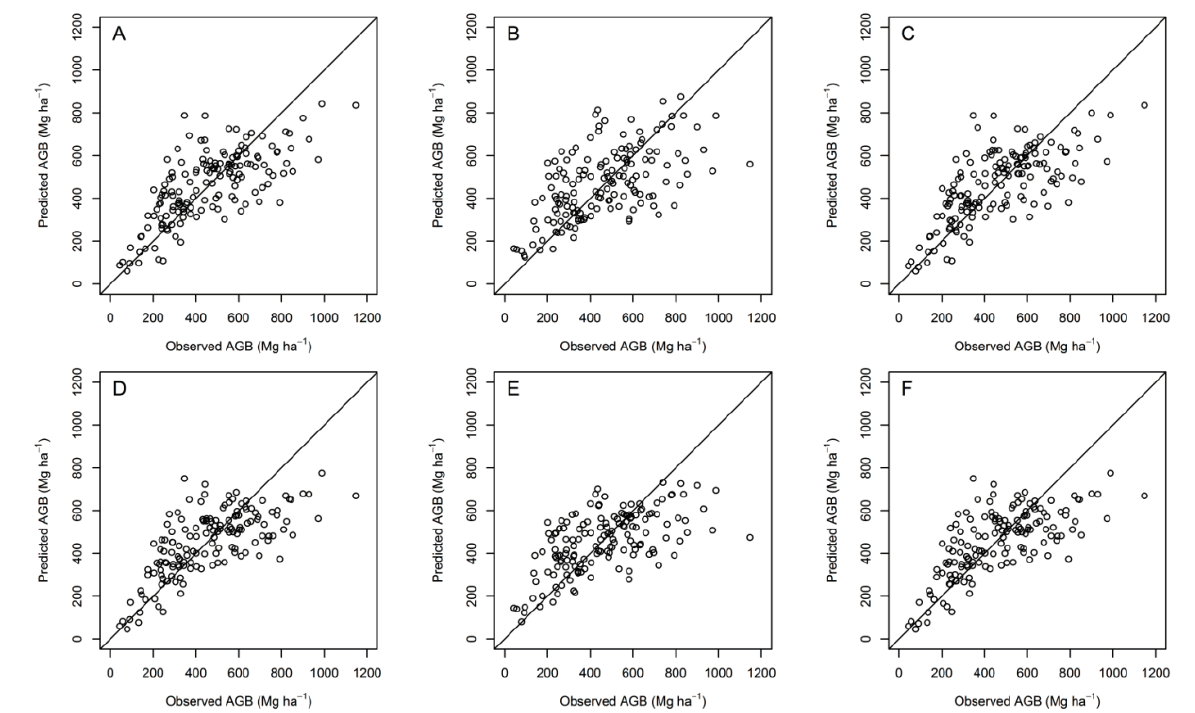
Figure 2. Scatter plots of observed versus predicted aboveground biomass (AGB) using logarithmic ( A–C ) or square root transformations of the response ( D–F ) in combination with vertical variables (A, D), texture variables (B, E) and both vertical and texture variables (C,